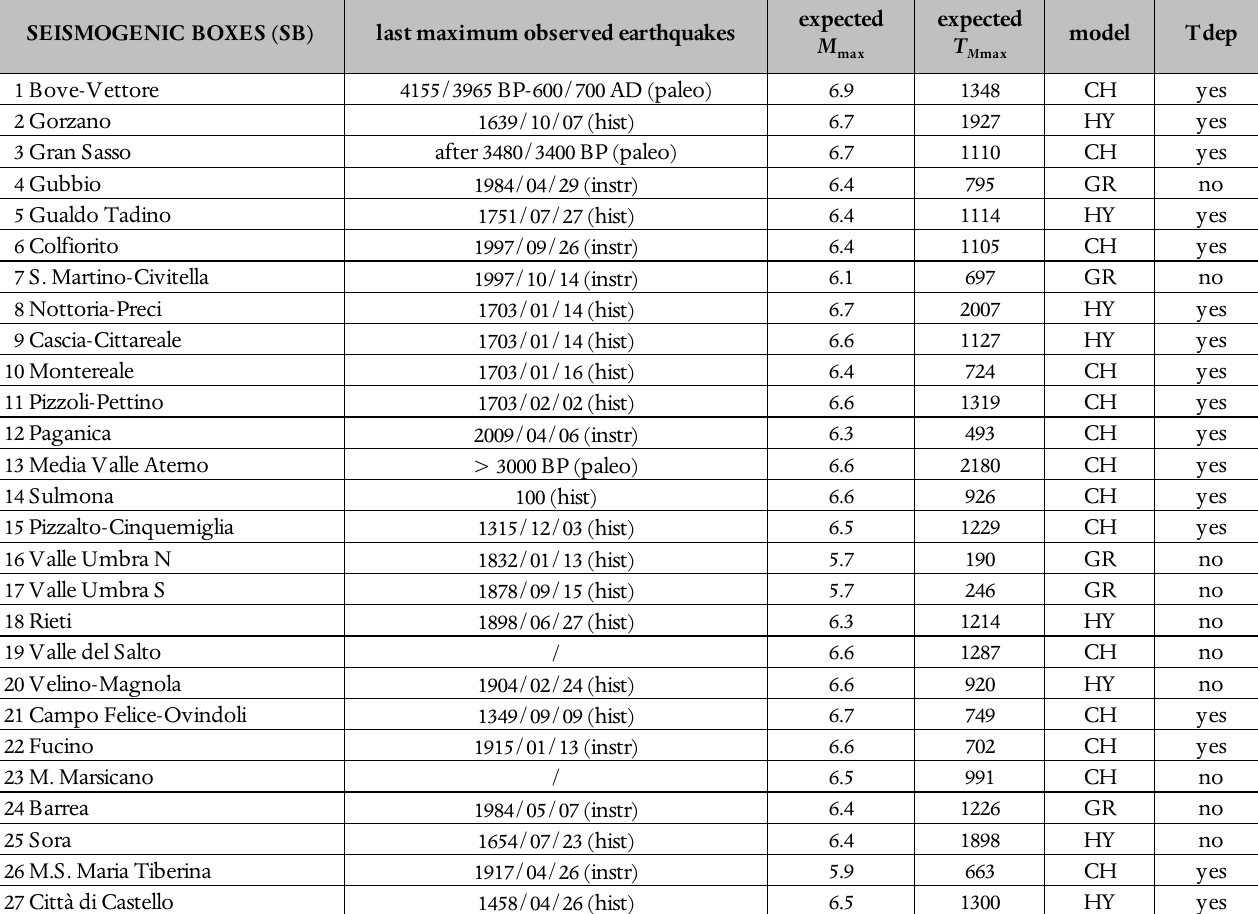
Table 2. Seismogenic boxes parameterization. Last maximum observed earthquakes were taken from: hist, CPTI Working Group [2004]; instr, instrumental catalog CSTI Working Group [2001], and ISIDE database available at http://iside.rm.ingv.it/iside; paleo, paleoseismological data from Galli et al. [2008] and references therein (for 13-Media Valle Aterno, Falcucci et al. 2009). «Expected M maximum magnitude and mean recurrence time [see details in Peruzza et al. 2010]. The type of model chosen was: CH bell-shaped approximation of a characteristic earthquake; GR, Gutenberg-Richter exponential distribution function; HY, hybrid model with a characteristic peak and a G-R tail for smaller magnitudes. The final column indicates if a time-dependent approach was used for the